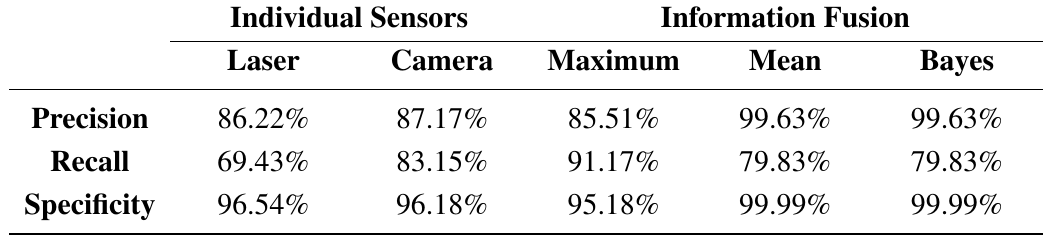
Table 8. Outdoor experiment results. Comparison of the fixed (a) and the proposed adaptive (b) projection methods. The performance of using each sensor individually is also compared with three different information fusion techniques. The data sets used for these results are shown in Table